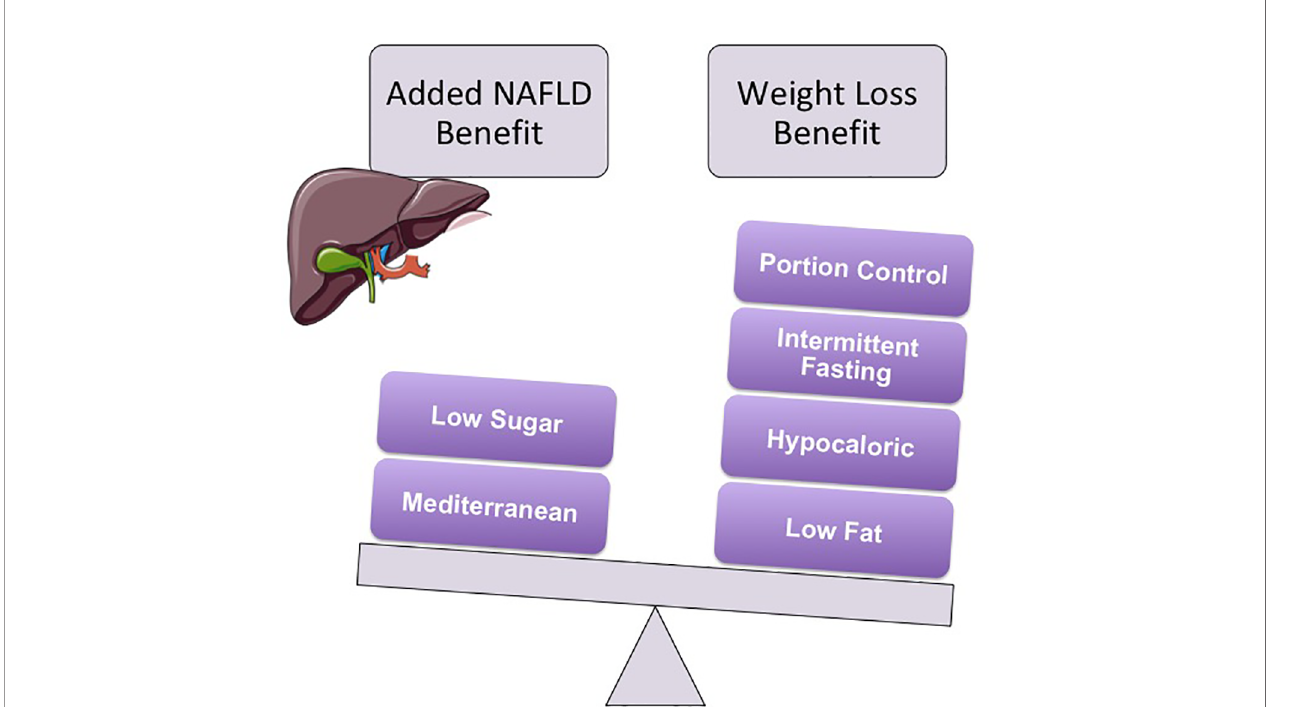
FIGURE 1 | Multiple diets have shown ef fi cacy for weight reduction in children. Ultimately, the best diet for weight management is the one that can be sustained over time. However, both the Mediterranean (i.e., low in red meat and high in fruits, vegetables, grains, nuts, grilled chicken and fi sh) and the low free sugar diet have shown added bene fi t in pediatric NAFLD, independent of weight reduction. Generally these diets are recommended in conjunction with regular exercise (e.g., at least 150 minutes/week of moderate intensity or >75 minutes/week of high intensity exercise), or moderate to vigorous physical activity daily for at least 20 minutes (with a target goal of 60 minutes